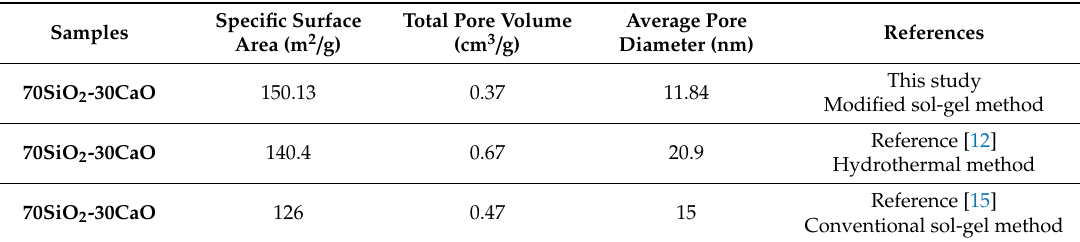
Table 2. Nitrogen adsorption / desorption characterization of bioactive glass 70SiO 2 -30CaO.